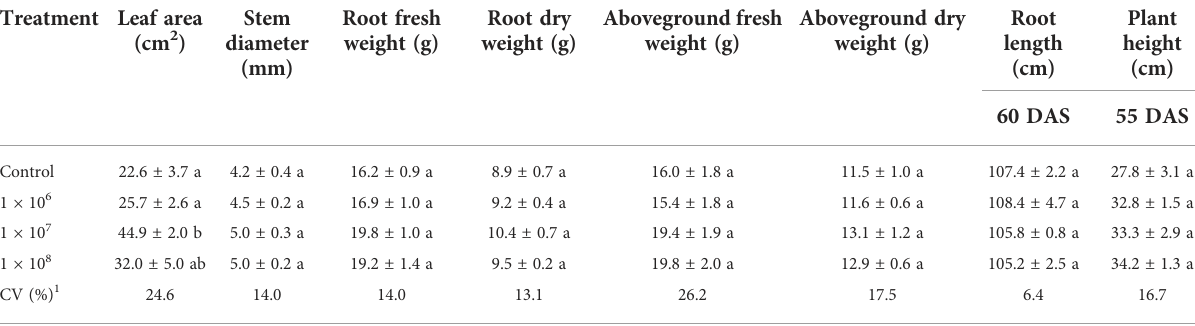
TABLE 4 Leaf area, stem diameter, root length, plant height and fresh and dry weight of the root and aboveground of cotton plants treated with different concentrations of Trichoderma asperelloides CMAA 1584. Treatment Leaf area (cm 2